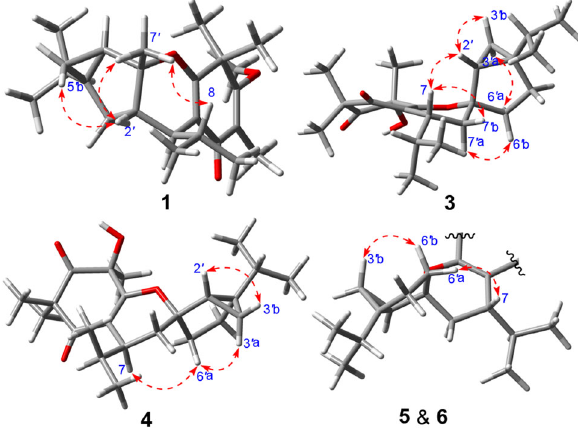
Fig. 3 Key ROESY correlations of 1 and 3 –